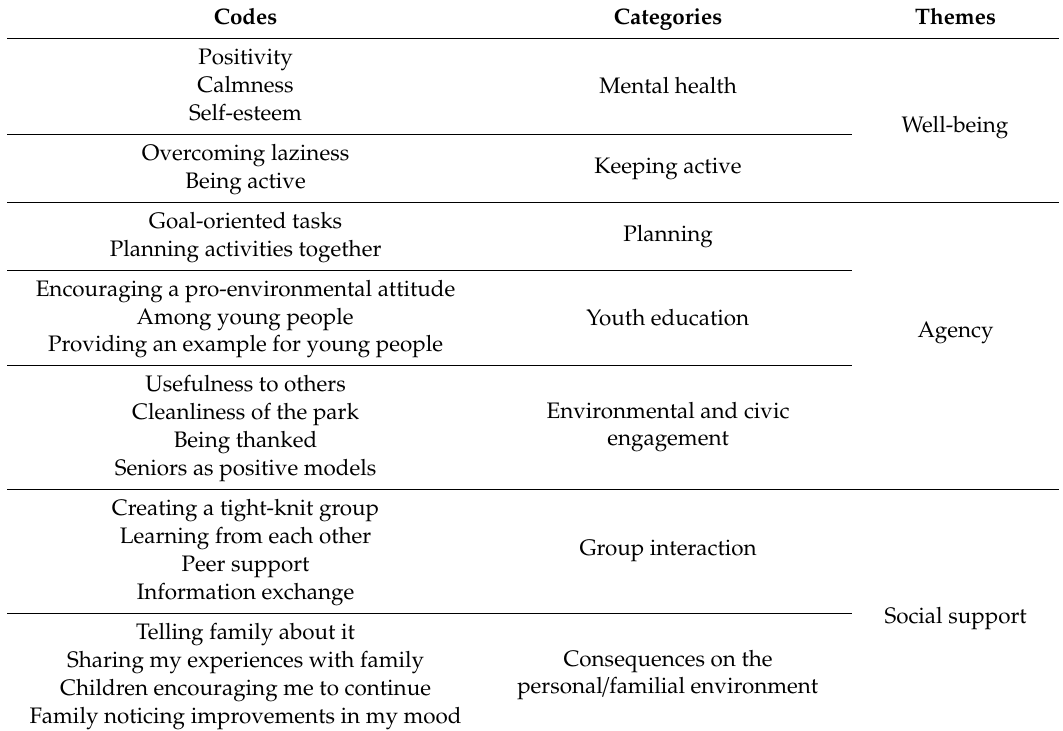
Table 5. Experienced